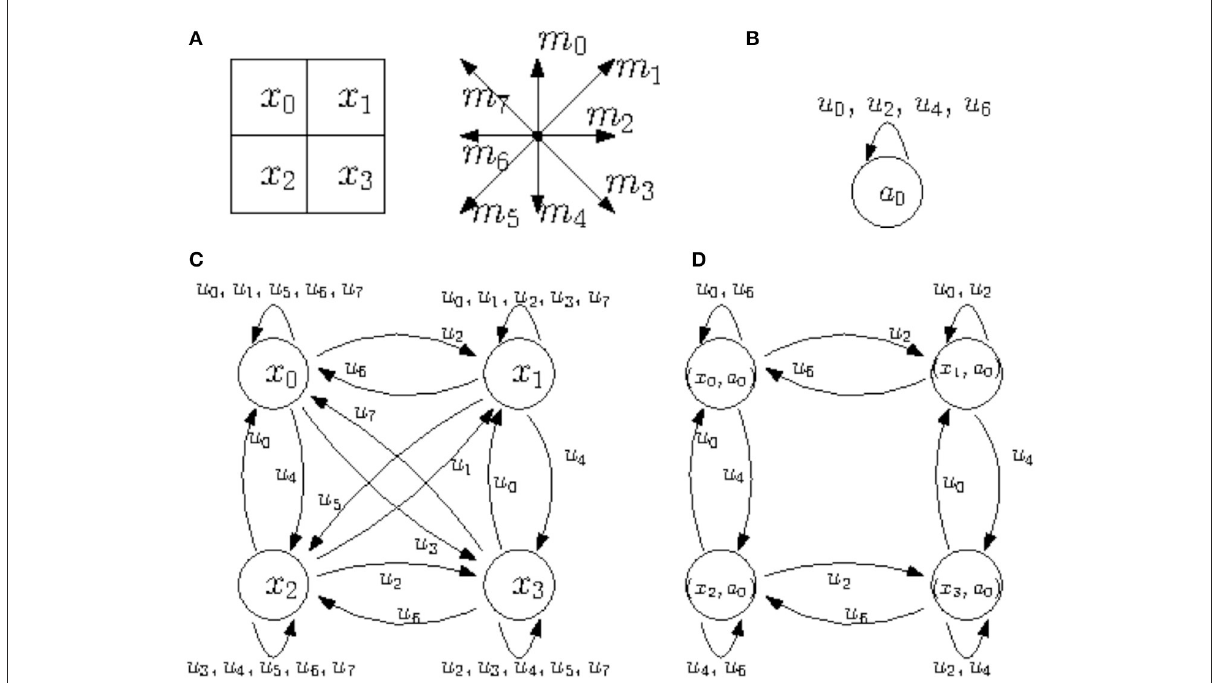
FIGURE2 (A) States and actions for the transition system X 0 that describes a 2-by-2 grid. 8 actions populating the set M = { m 0 , ... , m 7 } correspond to a move (to a neighbor cell if possible) either sideways or diagonally. Suppose S is a singleton such that S = { s } . Then, in the following, u i corresponds to the transition u i = ( m i , s ) for i = 1, ... ,7. (B) Transition system X 1 . (C) Transition system X 0 . (D) The coupled system X 0 ∗ X 1 .